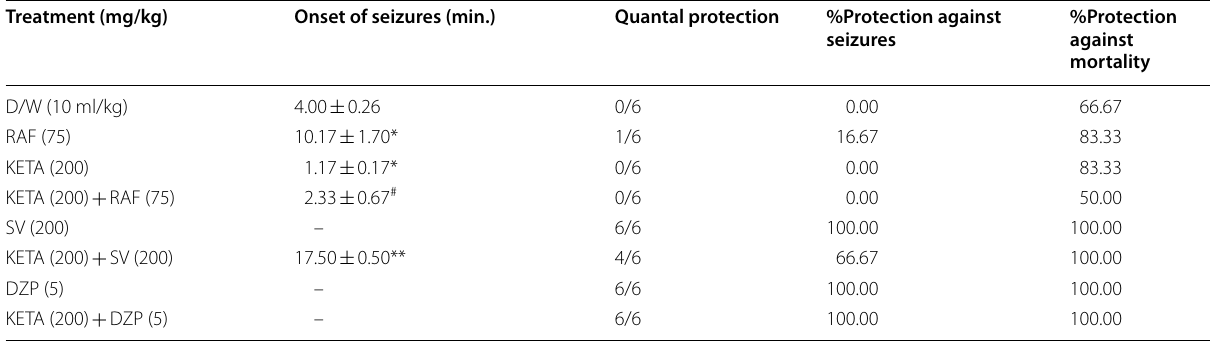
D/W, distilled water; RAF, residual aqueous fraction of KETA; KETA, ketamine; DZP, diazepam; SV, sodium valproate Values are presented as mean SEM ± * P < 0.05; ** P < 0.01 as compared to D/W group # P < 0.05 as compared to RAF group—One-way ANOVA followed by Tukey post hoc test, n